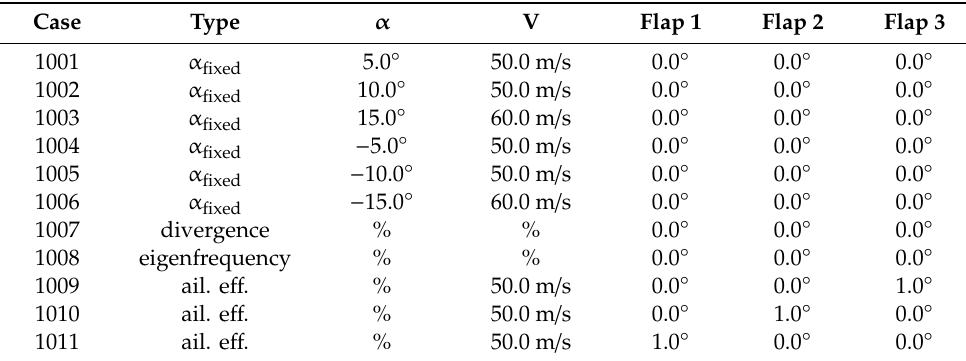
Table 2. Optimization load cases.